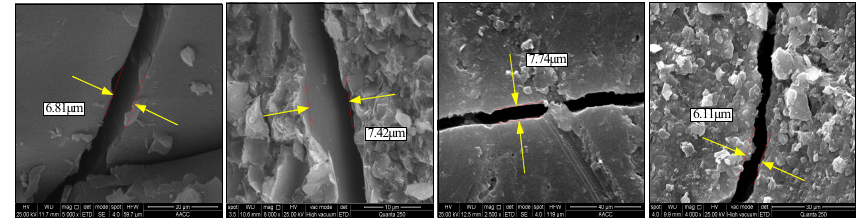
Figure 9. Microscopic crack structure of rock samples.